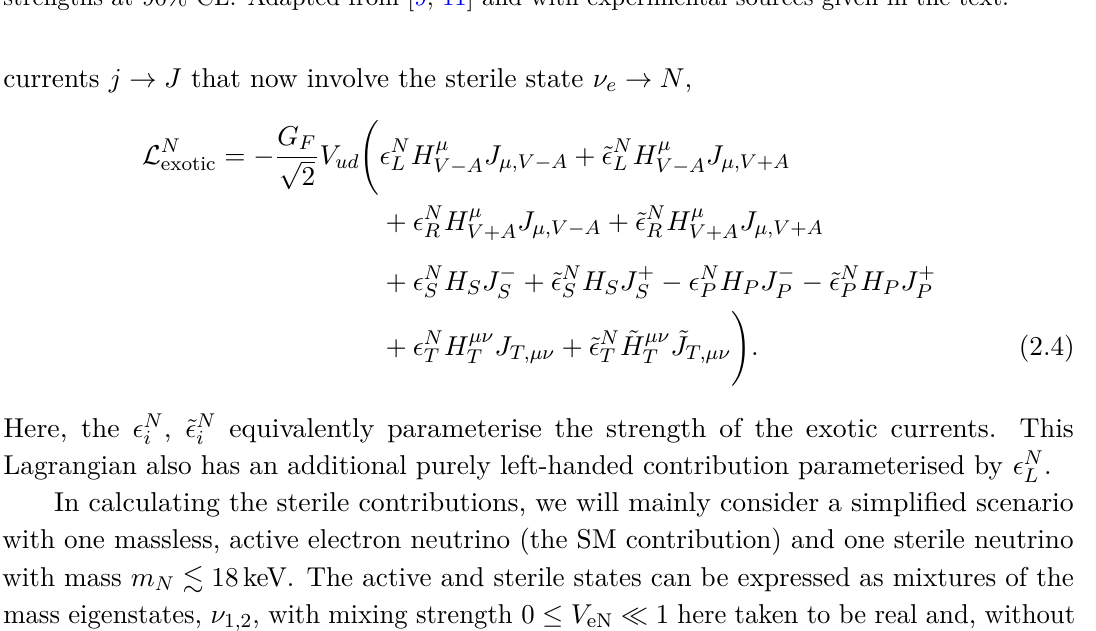
Table 2 . Experimental upper bounds on the real and imaginary parts of the exotic coupling strengths at 90% CL. Adapted from [9, 11] and with experimental sources given in the